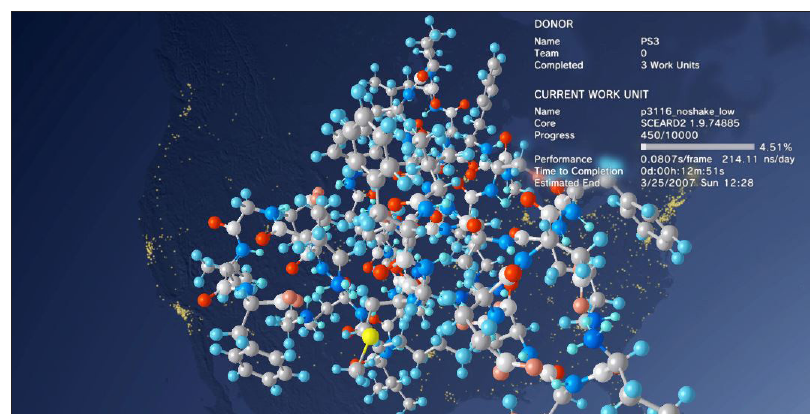
Figure 2: Folding@home screensaver showing protein folding simulation.